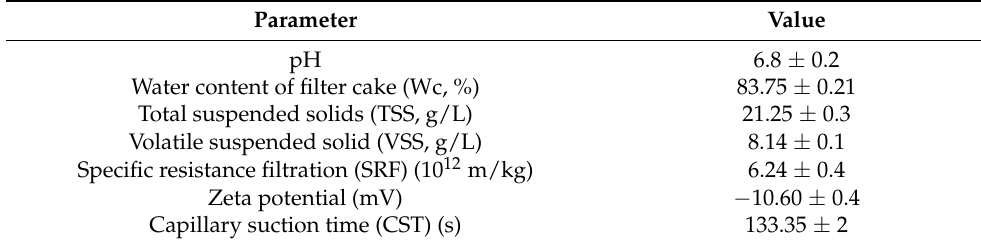
Table 1. Characteristics of raw